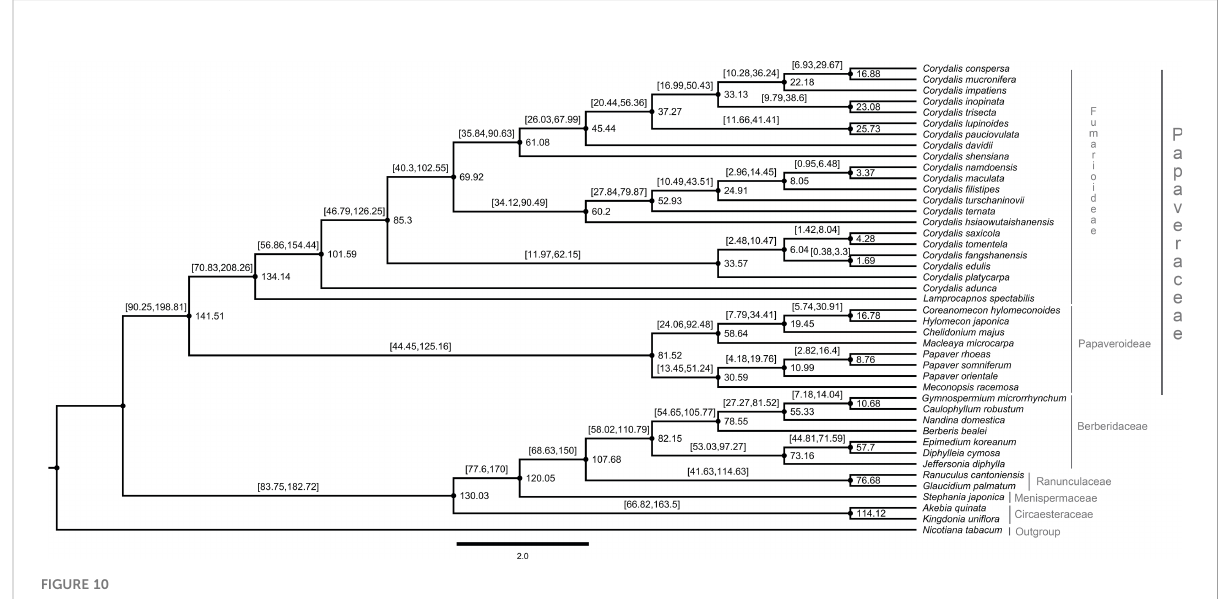
FIGURE 10 Estimation of the divergence time of Corydalis species using BEAST based on 59 plastid protein-coding genes of 42 Ranunculales and one outgroup species. The estimated mean ages are shown near the nodes, and blue bars represent 95% high posterior density.